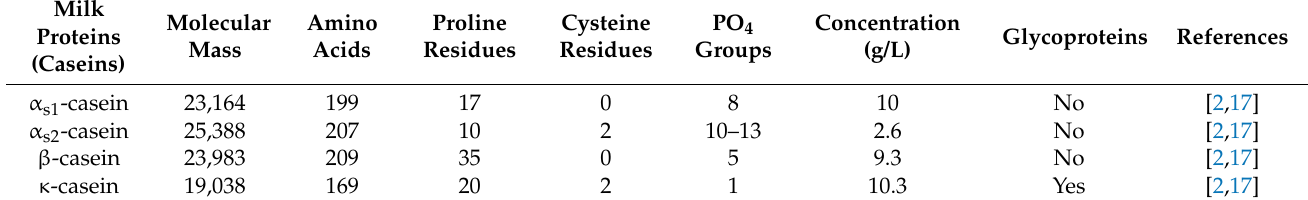
Table 1. Characterization of caseins based on molecular mass, amino acid numbers, proline, and cysteine residues. Milk Proteins